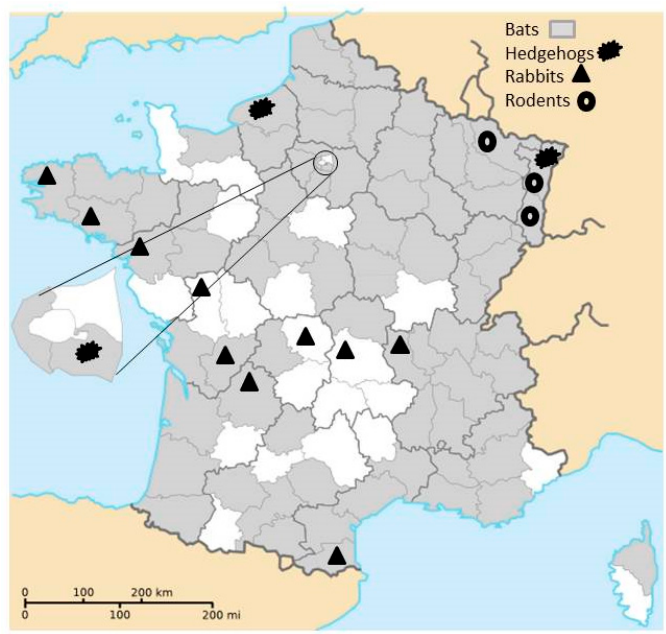
Figure 1. Different types of collected samples by French administrative department (excluding French Guyana in South America).